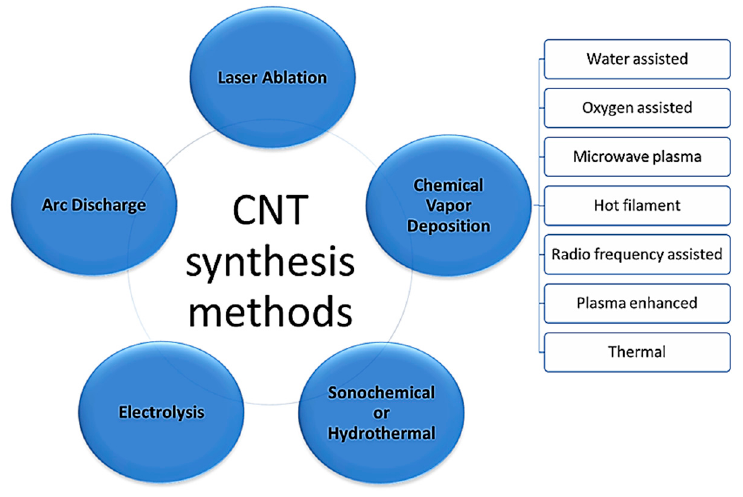
ff erent approaches to CNTs Figure 11. Different approaches to CNTs synthesis. Figure 11. Di Figure 11. Different approaches to CNTs synthesis.